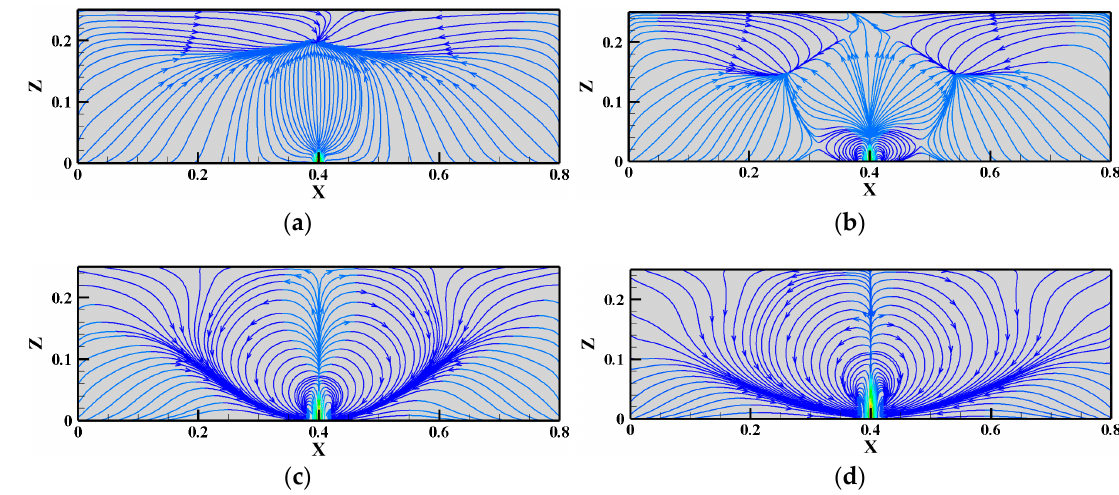
Figure 11. Vortex of the rectangular jet at cross-section Y = 0: ( a ) case 9, ( b ) case 10, ( c ) case 11, ( d ) case 12.